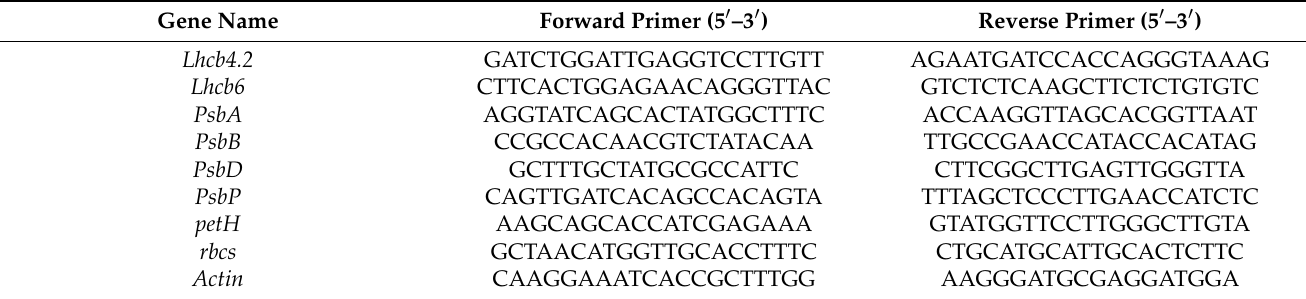
Table 1. Gene-specific primers list for